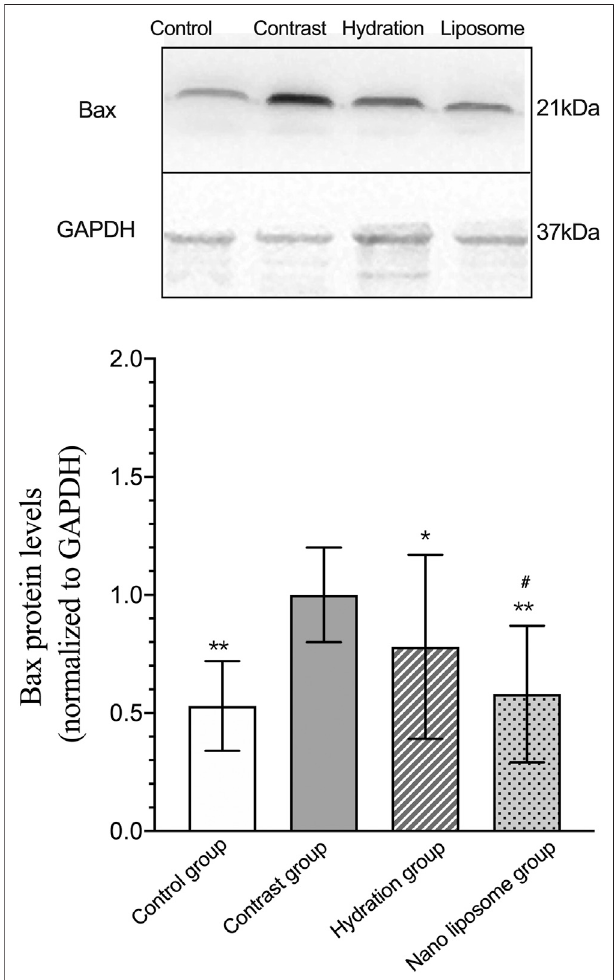
FIGURE10| RepresentativewesternblotresultsandanalysisoftheBax protein expression in the four groups. Bax: Bcl-2 subfamily, pro-apoptotic factor. Values are expressed as mean ± SD. *Compared with the contrast group, p < 0.05. **Compared with the contrast group, p < 0.01. # Comparedwiththehydrationgroup, p < 0.05. ## Compared withthehydration group, p <